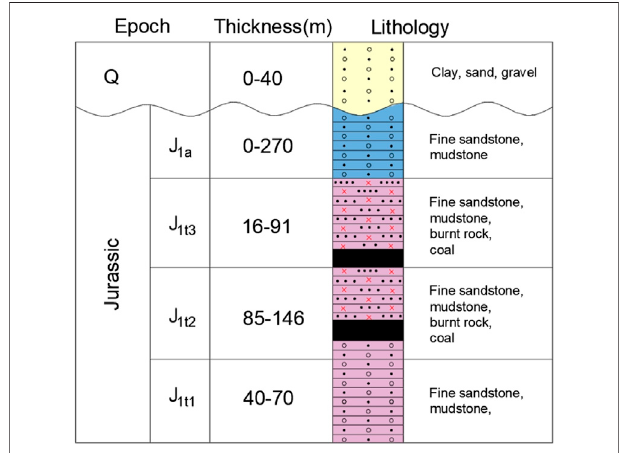
FIGURE 3 | Stratigraphic column of the study